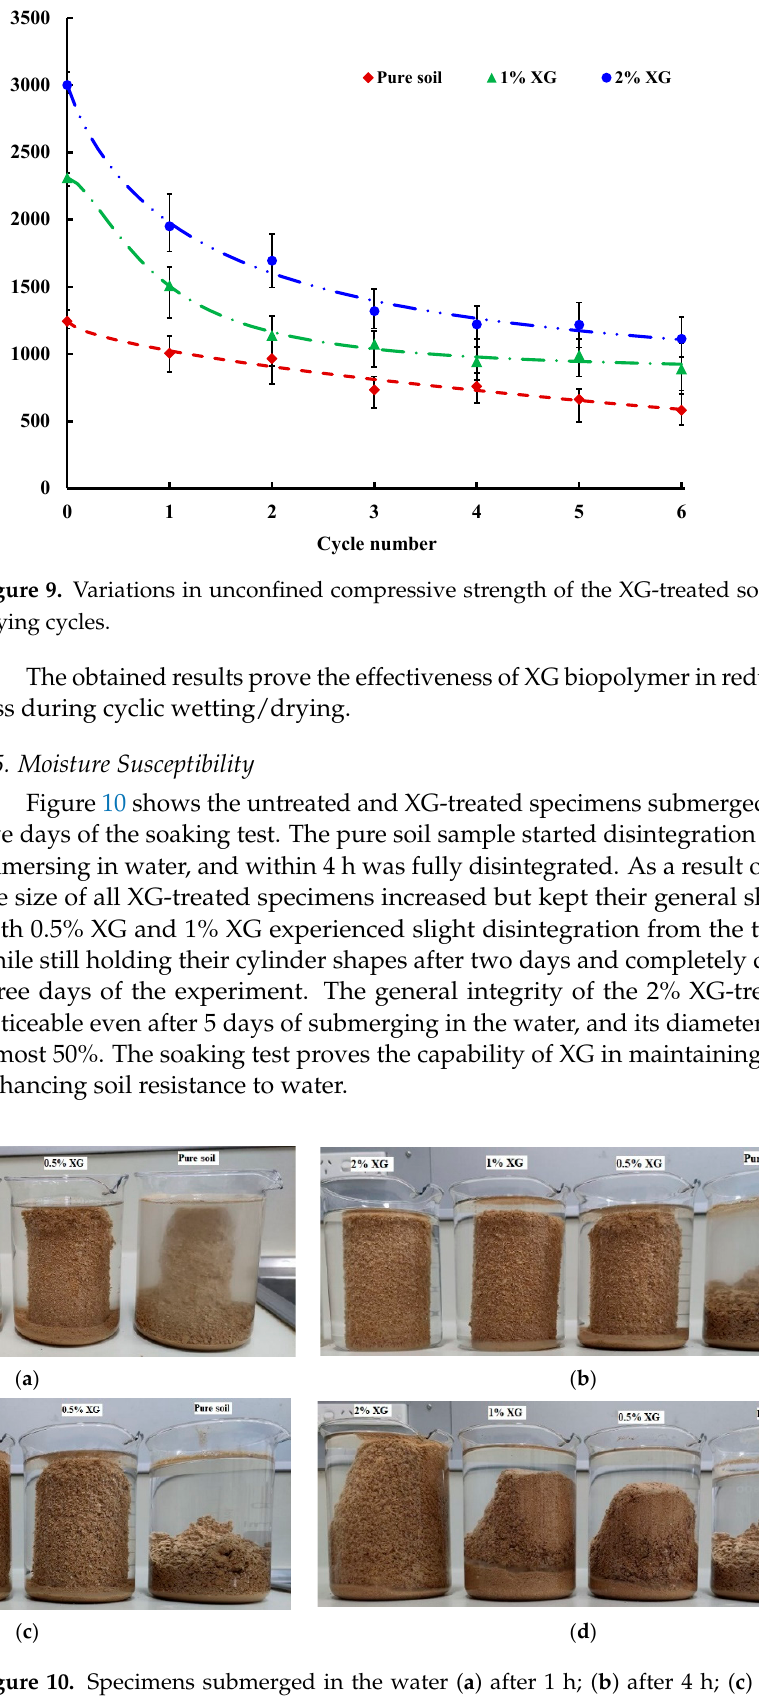
Figure 10. Specimens submerged in the water ( a ) after 1 h; ( b ) after 4 h; ( c ) after 24 h; ( d ) after five days.